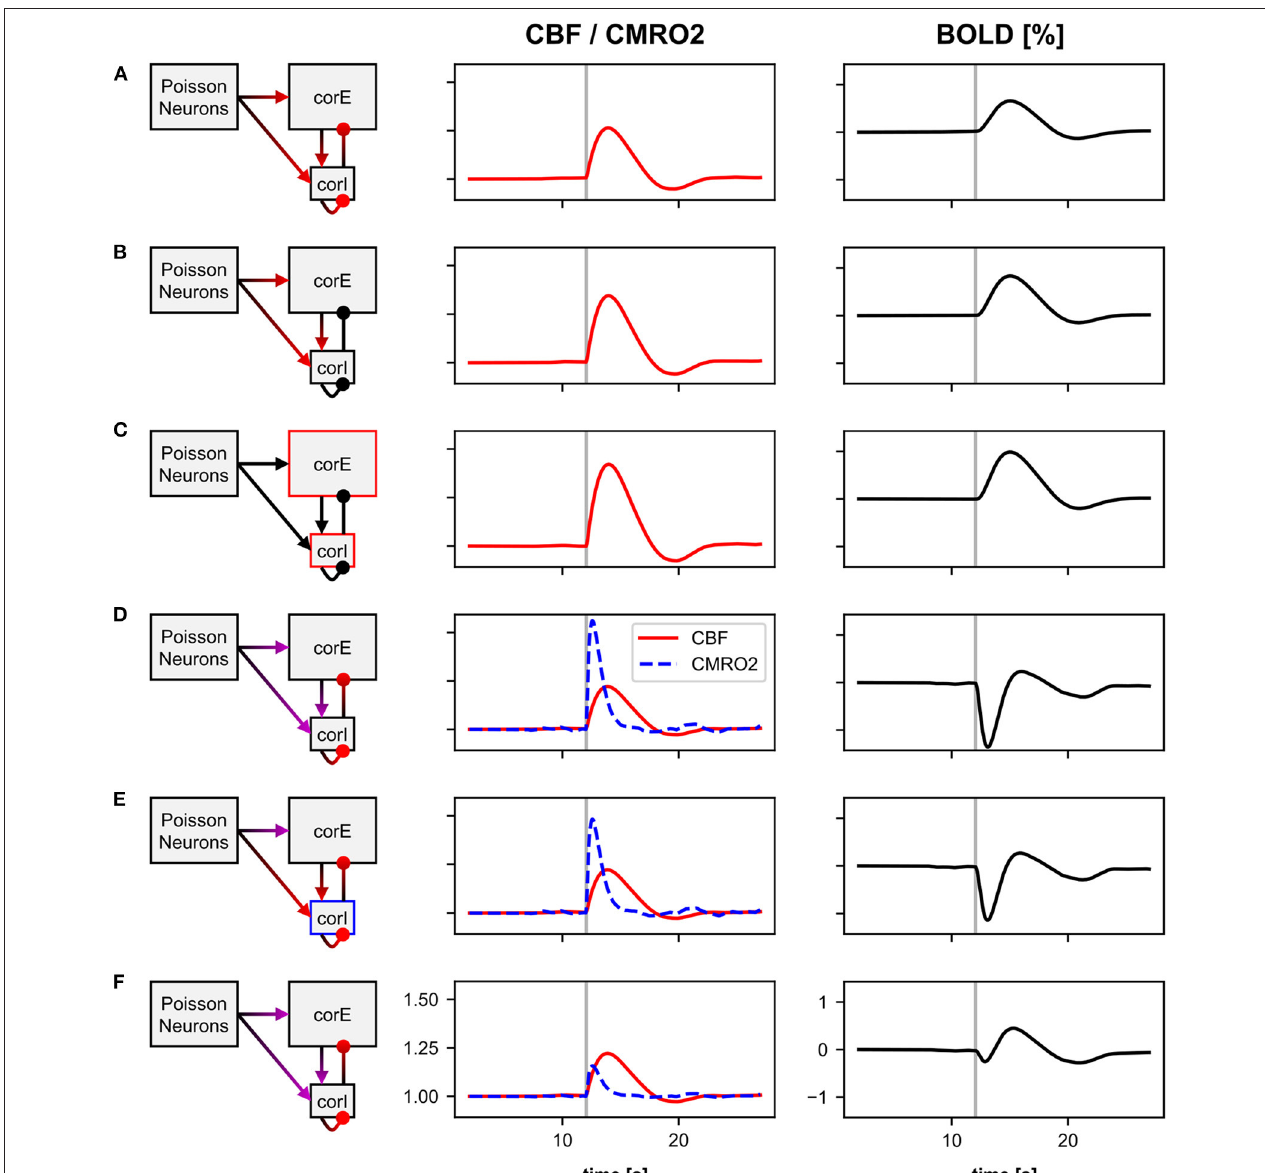
FIGURE 6 | Normalized CBF, CMRO2, and BOLD (relative change) responses of six different BOLD monitors including different source variables. The averaged recordings of 40 simulations with a 100 ms stimulus pulse are shown. The vertical gray bar in columns two and three indicate the time window of the active stimulus pulse. The left column illustrates, which compartments of the microcircuit model were used as source variables for the BOLD monitors. red, CBF-driving; blue, CMRO2-driving; purple, CBF and CMRO2-driving. For a more detailed description about the source variables see Section 4.3 and Table 1 . The BOLD monitors (A–C) using the classic Balloon model with a single CBF-driving input signal. The BOLD monitors (D–F) using the two-input Balloon model defined in this work with two input signals driving CBF and CMRO2